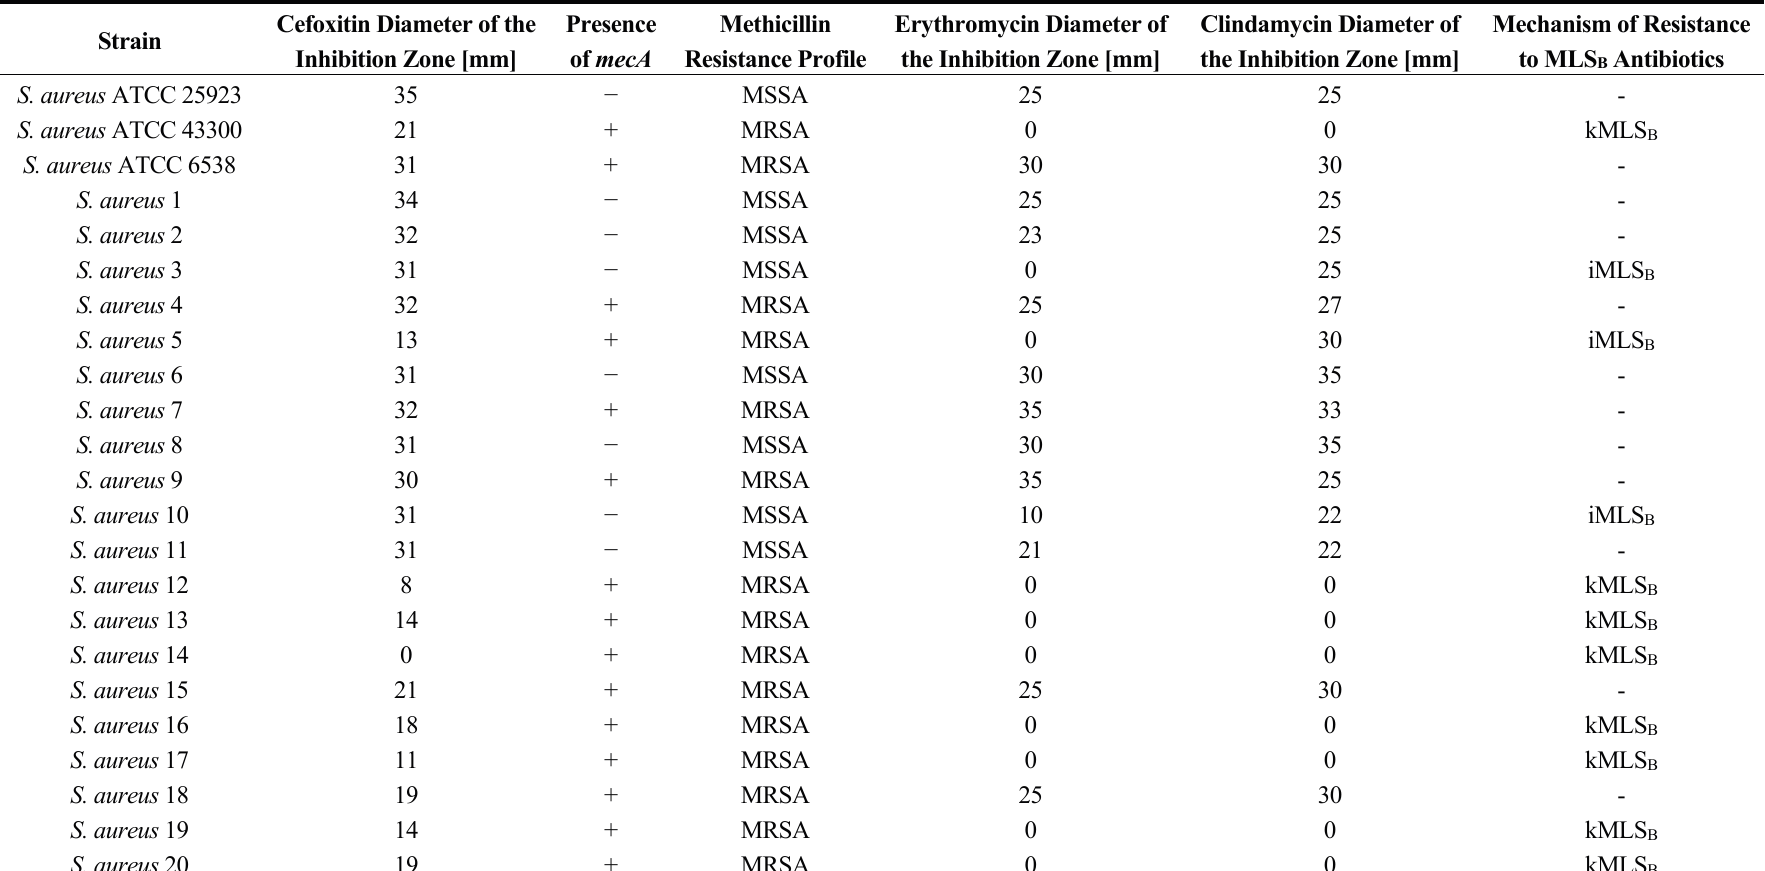
Table 1. Staphylococcus aureus susceptibility to methicillin and MLS B antibiotics assessed by the disc diffusion method (Cefoxitin test and D-test) and molecular technique (detection of mecA